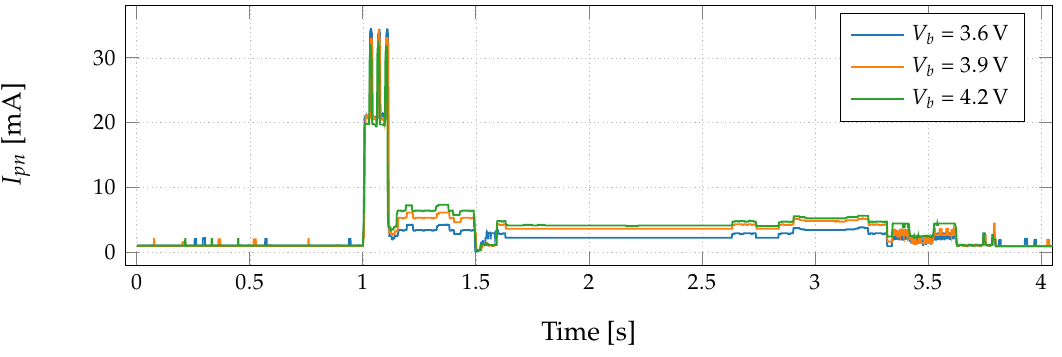
Figure 2. Measured current of PhyNode at different operational